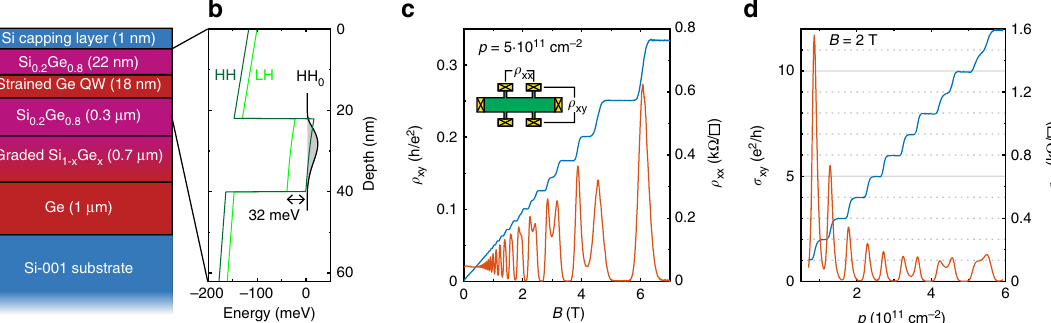
Fig. 1 Ge/SiGe heterostructure and magnetotransport measurements. a Schematic representation of the full heterostructure (dimensions not to scale). b Simulated band structure within the SiGe – Ge – SiGe heterostructure, showing strain-induced splitting of the heavy and light hole band edges and strong con fi nement of heavy holes in the Ge. c , d Magnetotransport measurements in a perpendicular magnetic fi eld B , showing clear Shubnikov – de Haas oscillations and quantised Hall conductance as a function of B ( c ) and the carrier sheet density p ( d ) as converted from the top gate potential using low-